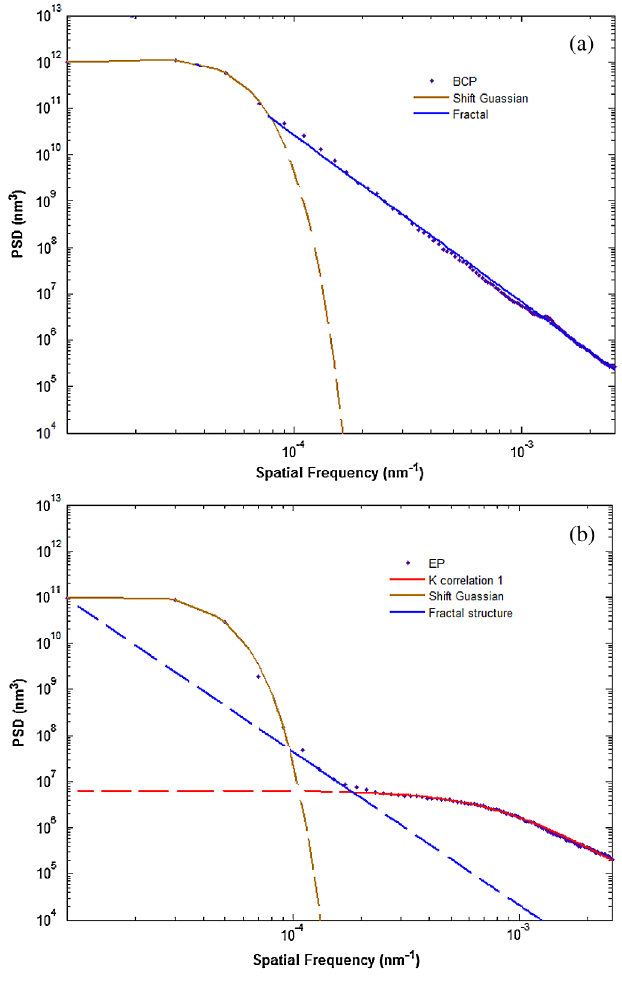
FIG. 16. Average 1D PSD from fine-grained sample after removal of (a) 100 (cid:1) m BCP or (b) after 50 (cid:1) m EP. The range of fitting for each component is indicated by the solid